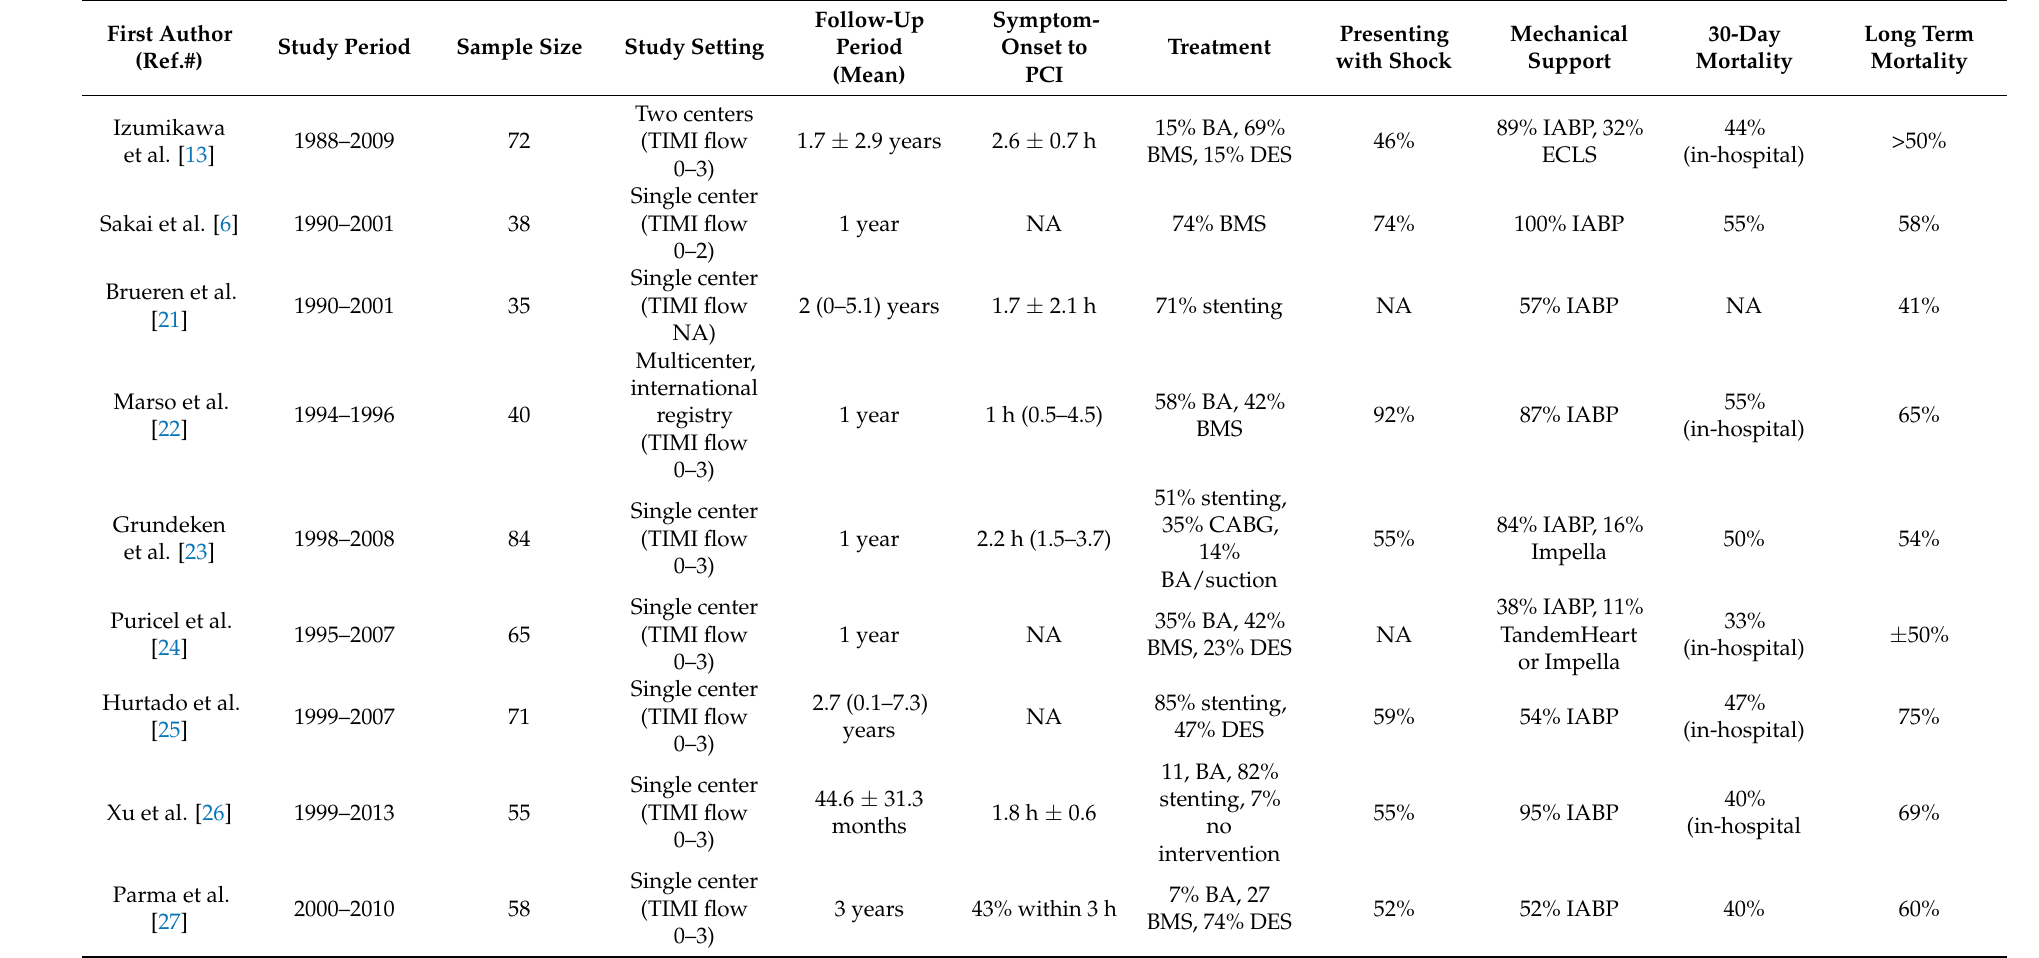
Table 5. Previous studies on acute myocardial infarction due to unprotected left main coronary